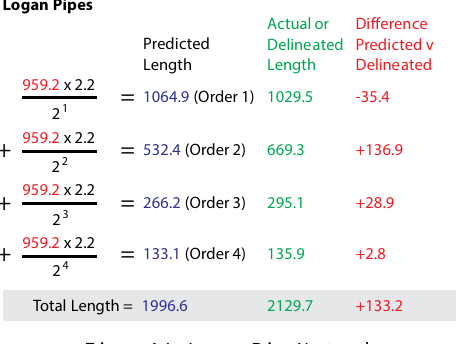
Figure 14, Logan Pipe Network